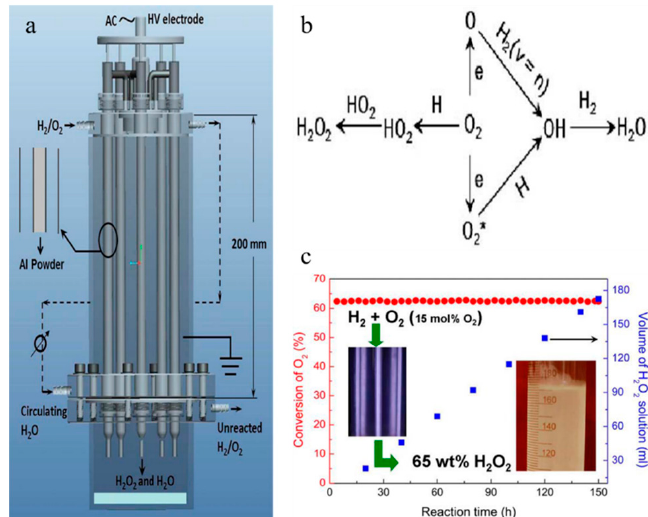
Figure 10. ( a ) diagram of double DBD reactor H 2 O 2 synthesis device; ( b ) the main reactions network for formation of H 2 O 2 and H 2 O in H 2 / O 2 nonequilibrium plasma; ( c ) the relationship between O 2 conversion, H 2 O 2 product solution volume and reaction time. Reproduced with permission from [117]; Copyright Wiley, 2014.